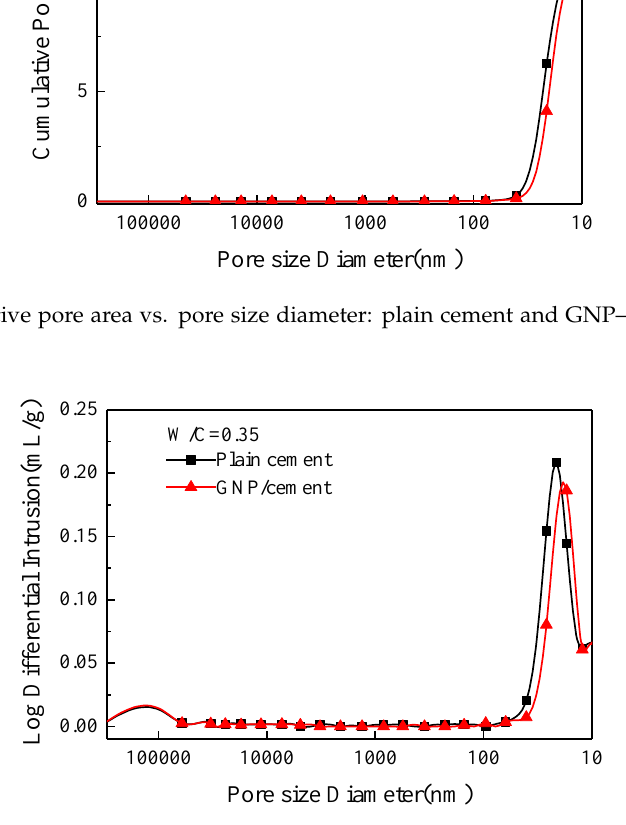
Figure 10. Pore size distribution of plain cement and GNP–cement composite at 28 days. Table 2. Mercury intrusion porosimetry (MIP) analysis of plain cement and GNP–cement composite at 28 days.